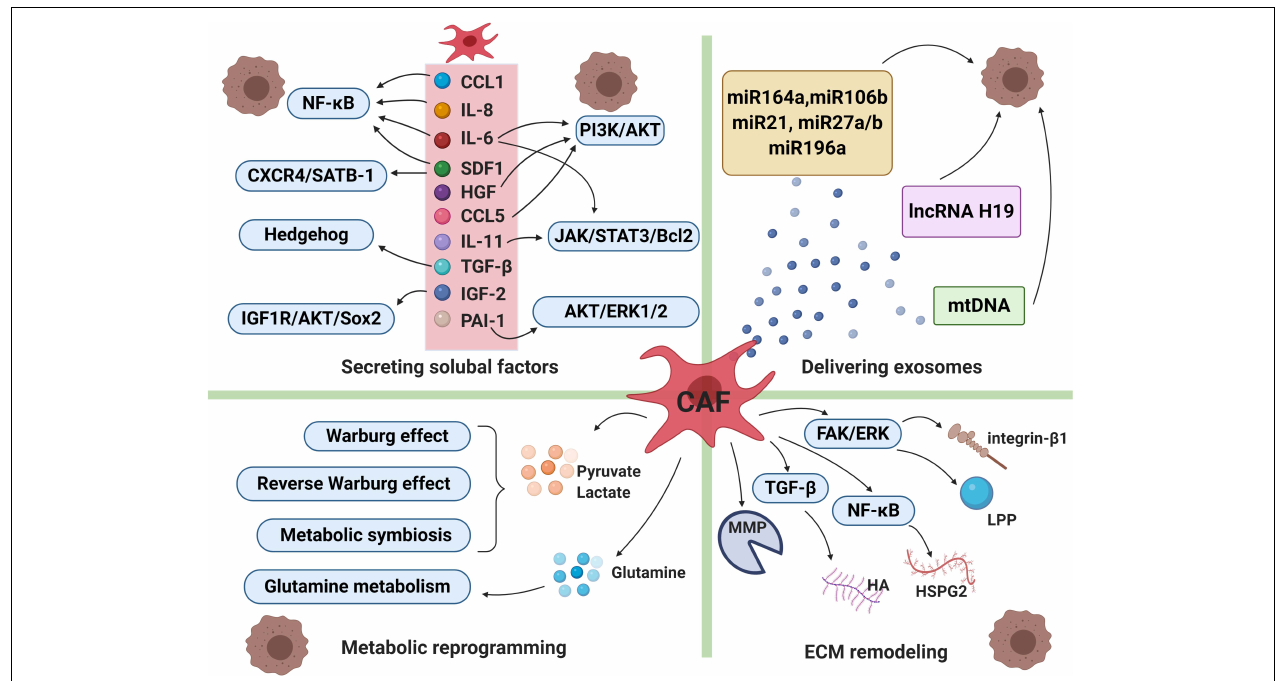
FIGURE 2 | Cancer-associated fibroblasts and drug resistance. The intricate mechanisms of drug resistance mediated by CAFs include secreting soluble factors, delivering exosomes, metabolic reprogramming and extracellular matrix (ECM) remodeling. CAFs can secret a broad range of cytokines or factors which enable to activate a series of signaling cascades, leading to therapeutic resistance. CAFs-derived exosomes deliver miRNAs, lncRNAs and mtDNA to cancer cells, which participate in transmitting paracrine signals of therapeutic resistance. Moreover, in order to adapt to a glucose-deficient microenvironment, CAFs coordinate with tumor cells to modulate metabolic mode. Lastly, activated signals within CAFs increased production of extracellular matrix components, resulting in changes of its physical and biochemical characteristics under therapeutic pressure. CCL1, chemokine C-C motif ligand-1; CCL5, chemokine C-C motif ligand-5; IL-6, interleukin-6; IL-8, interleukin-8;IL-11, interleukin-11; SDF1, stromal cell derived factor-1; HGF, hepatocyte growth factor; TGF-ß, transforming growth factor- β ; IGF-2, insulin-like growth factor 2; PAI-1, plasminogen activator inhibitor-1, MMP, matrix metalloproteinase; HA, hyaluronan; HSPG2, heparin sulphate proteoglycan 2; LPP, lipoma-preferred partner. The figure was created with